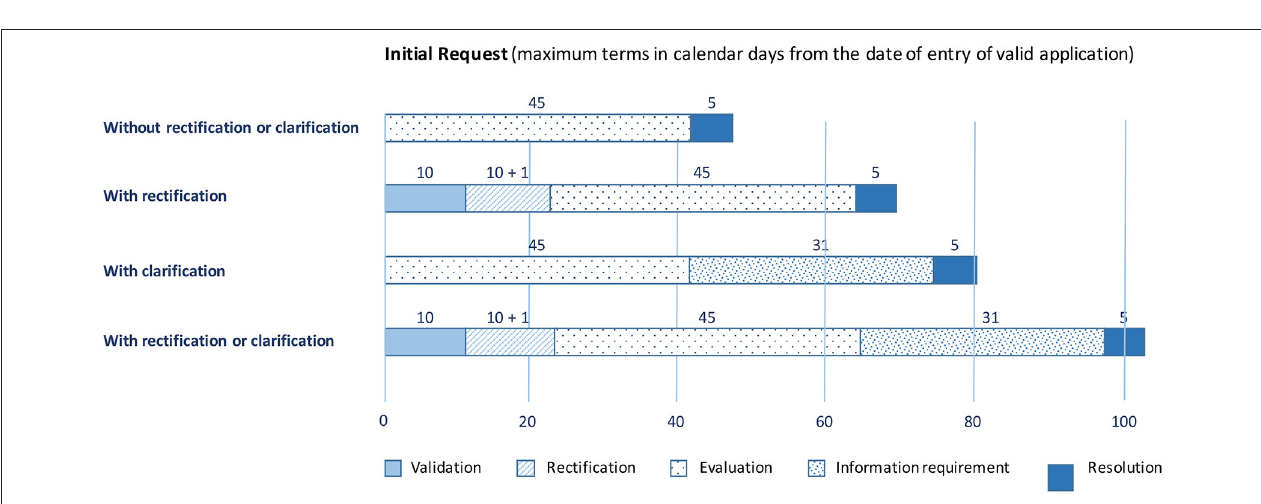
FIGURE 4 | Due dates after Spanish Agency of Medicines and Medical Devices (AEMPS) document